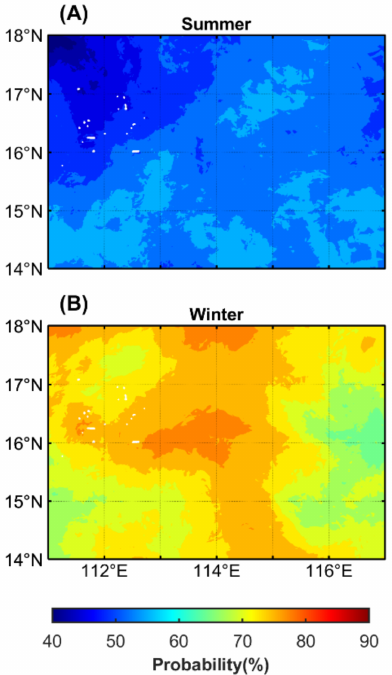
Figure 11. Spatial distributions of the occurrence probability of B 0 > 0 on the sea surface. The panel ( A ) shows averaged results in July (January) from 2017 to 2019, ( B ) representing summer